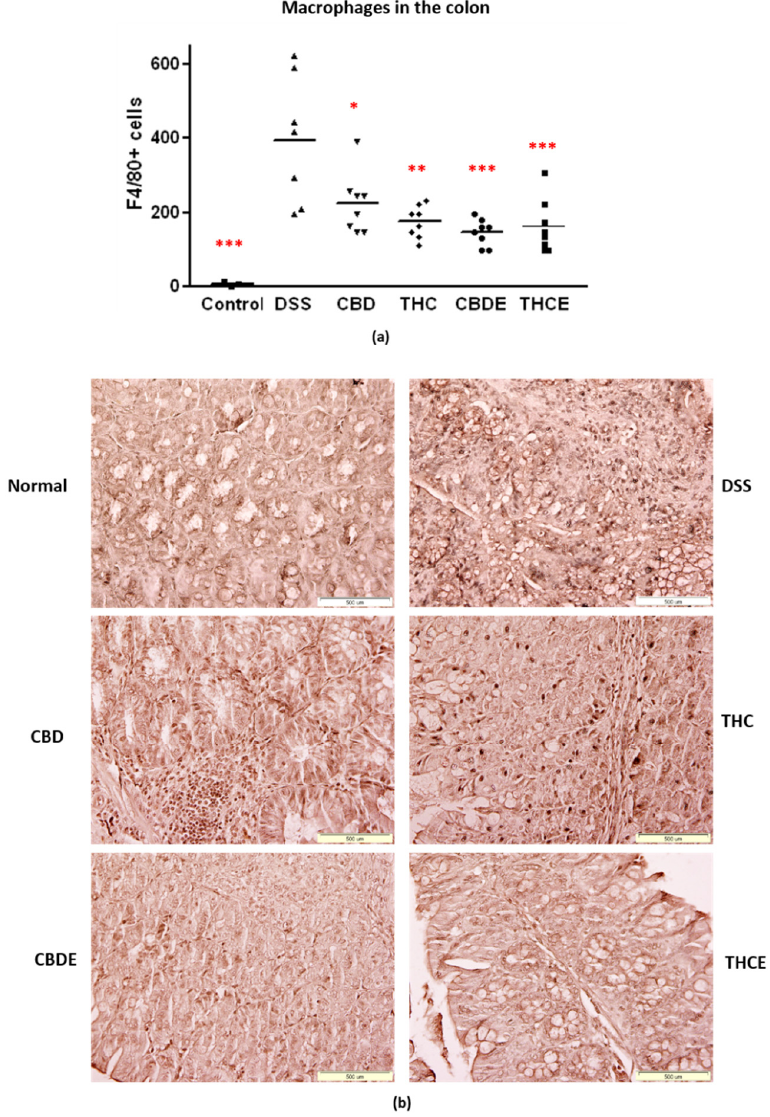
Figure 6. Immunostaining for macrophages in the colons of DSS model mice. Paraffin sections were stained with anti-F4/80 antibodies: ( a ) Average number of positive cells. p -value as compare with the DSS control group *, <0.05;**, <0.01; ***, <0.001. The difference between the CBDE and CBD groups is significant; ( b ) representative pictures of F4/80 immunostained sections. DSS—dextran sodium sulfate; THC—D9 tetrahydrocannabinol; CBD—cannabidiol; THCE—high THC cannabis extract; CBDE—high CBD cannabis extract.